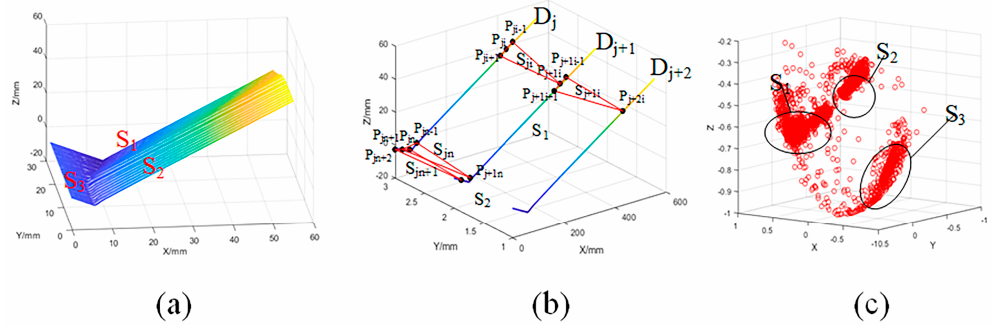
Figure 4. 3D zigzag-line welding seams point cloud data neighborhood normal vectors; ( a ) Point cloud data; ( b ) Method for establishing neighborhood normal vectors; ( c ) Neighborhood normal vectors.